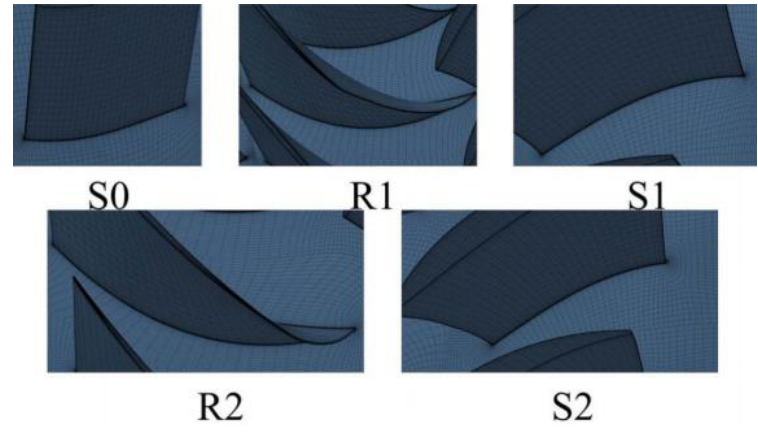
Figure 3 . Details of grid meshing for the front two stages . Figure 3. Details of grid meshing for the front two stages.